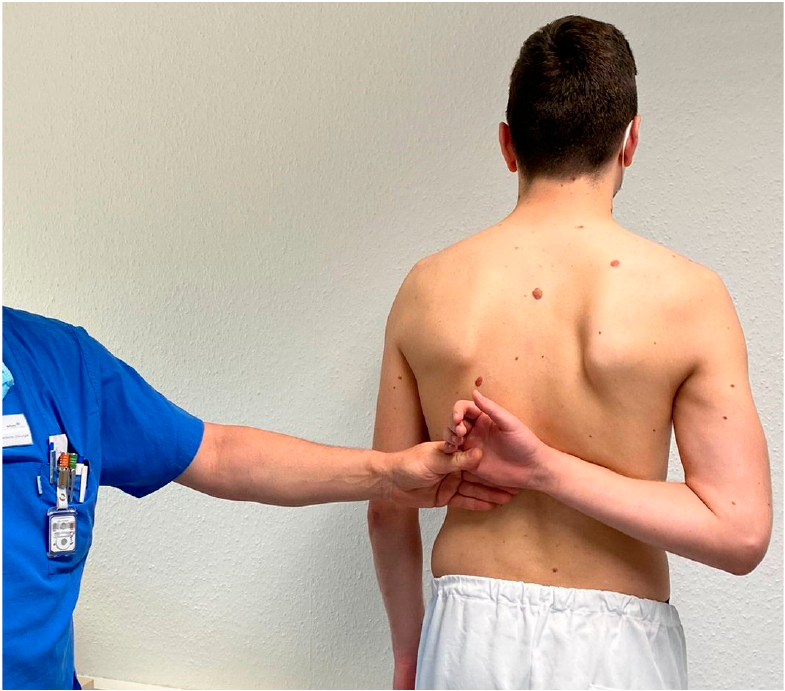
Figure 1 . Passively applying elevation overpressure (shoulder adduction and internal rotation) to the patient’s end range of motion.